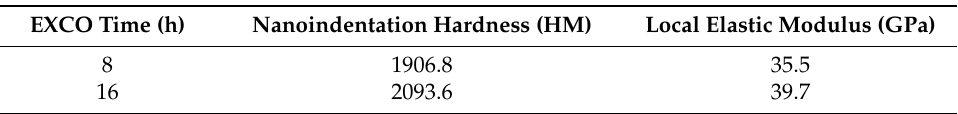
Table 1. Nanoindentation hardness values (HM) and local elastic modulus (GPa) at the bottom of the pits (0 µ m).